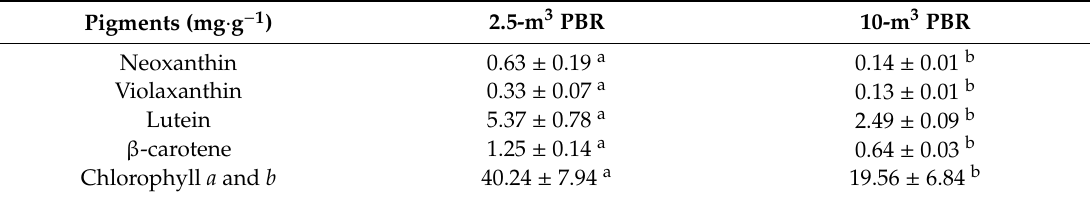
Table 4. Pigment profile of Chlorococcum amblystomatis biomass grown in 2.5- and 10-m 3 tubular photobioreactors (PBR). Di ff erent letters indicate significant di ff erences between reactors. Values are given as means ± standard deviation ( n =